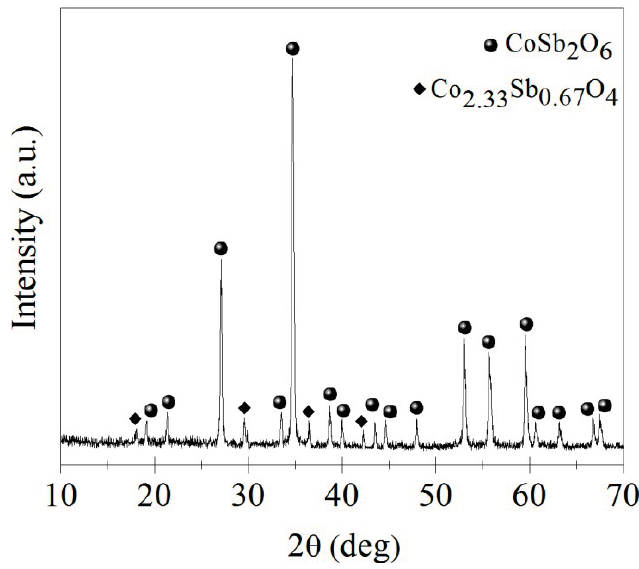
O powders calcined at 600 °C in 2 6